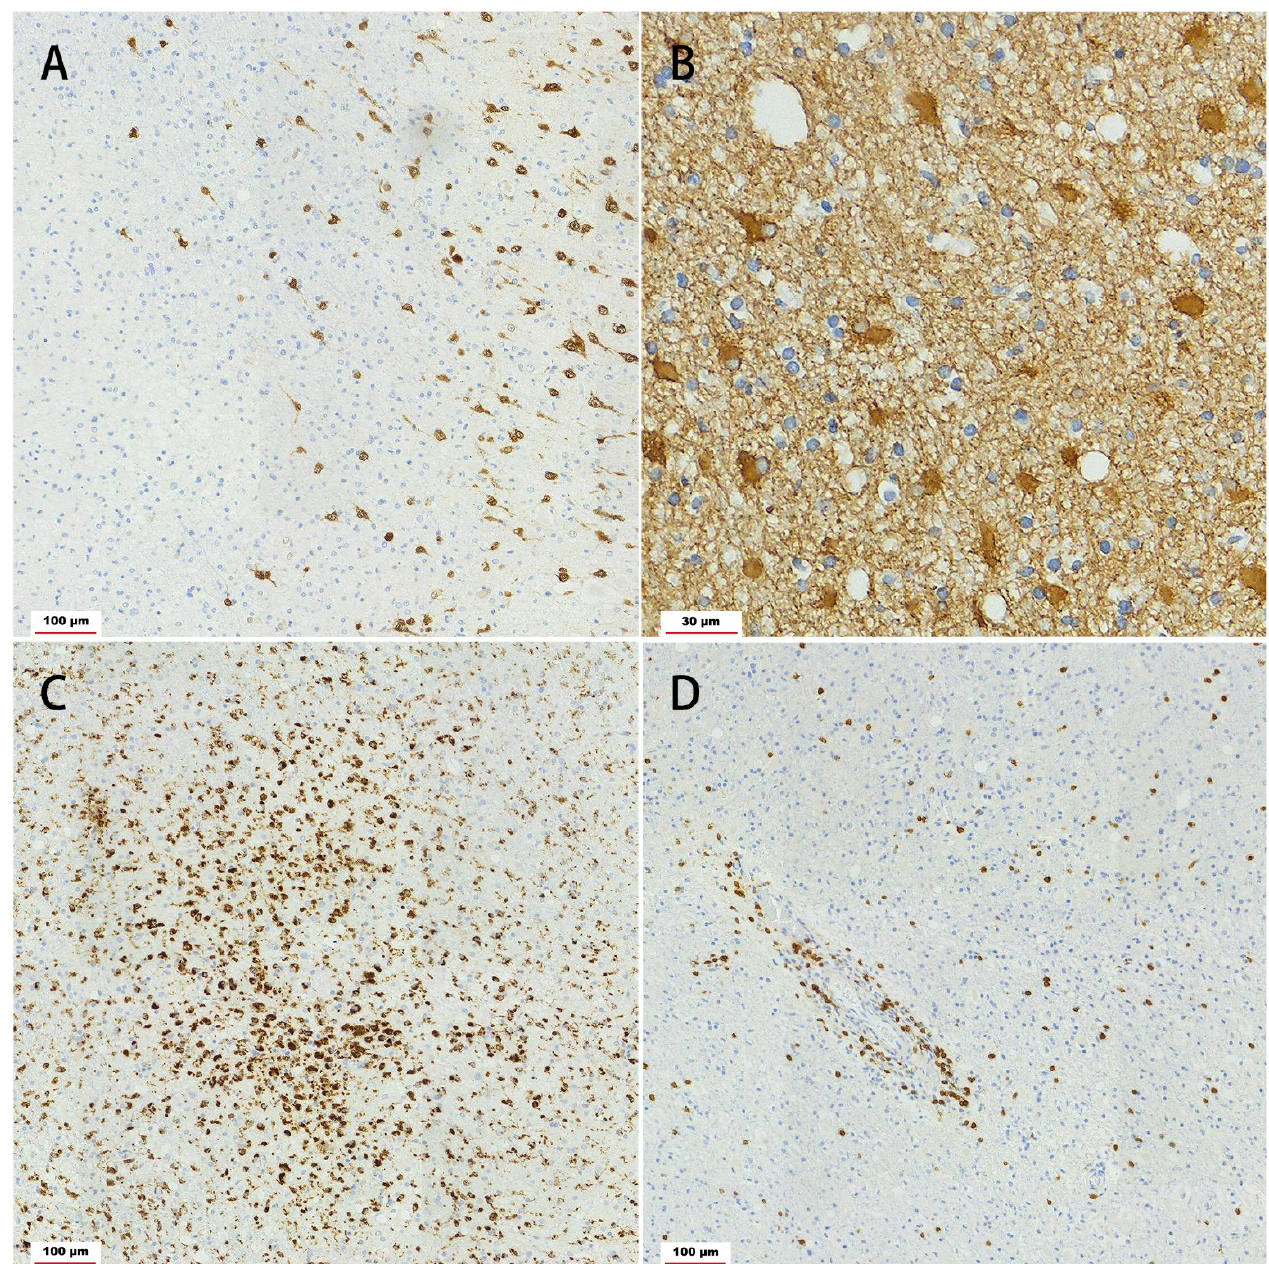
Figure 3. Light microscopy of the brain biopsy. Staining for neuronal nuclear antigen showed the loss of cortical neurons in the left side, whereas intact neurons were found in the right side ( A , Scale Bar = 100 μ m). The same areas were stained for glial fibrillary acidic protein, showing strongly activated astrocytes ( B , Scale Bar = 30 μ m). CD68 staining revealed the presence of microglial nodules in the cerebral cortex ( C , Scale Bar = 100 μ m). CD3 staining revealed the parenchymal and perivascular cuffing with T lymphocyte ( D , Scale Bar = 100 μ m).